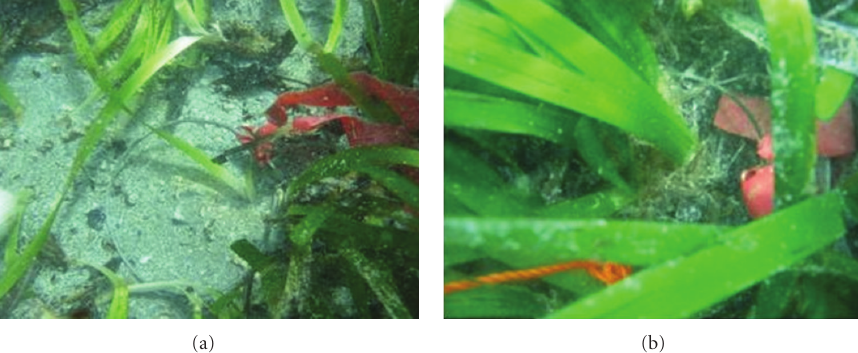
Figure 2: (a) P. sinuosa meadow recovery (Southern Flats), one new shoot after three months within the core marker ring; (b) P. australis meadow recovery (Southern Flats), control with five shoots.